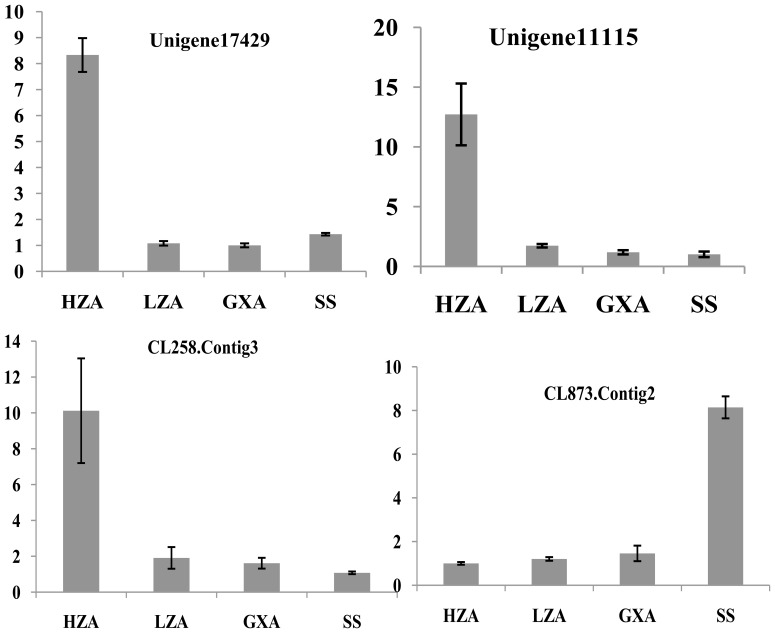
qRT-PCR analysis of four selected genes from P. xylostella that showed differential expression with differential resistance levels, as based on RNA-seq analysis.Error bars indicate the average deviations of the three replicates.